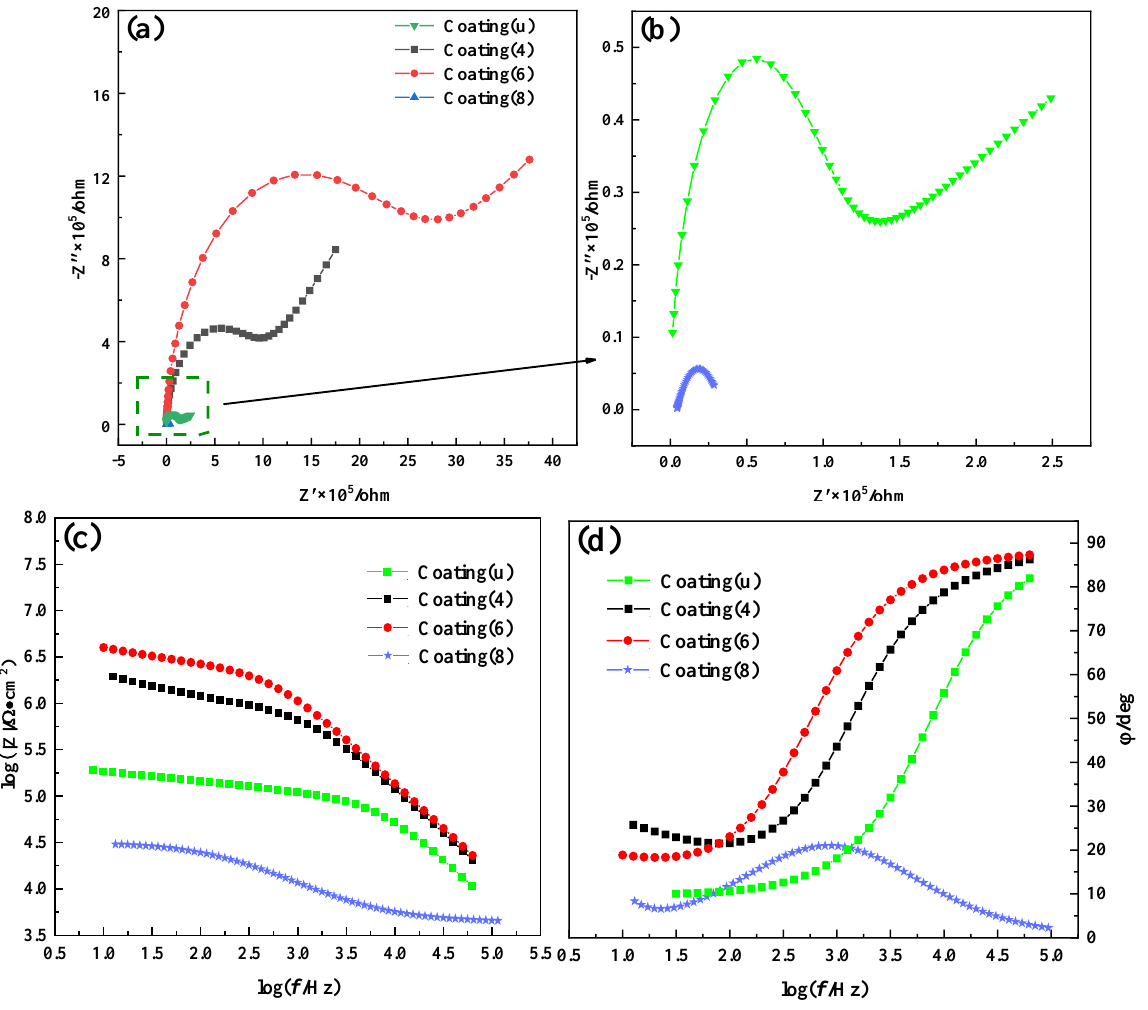
Figure 9. ( a ) Nyquist plots of coating(u) and coating(x) (x = 4, 6, 8); ( b ) magnified view of coating(u) and coating(8); ( c ) impedance frequency diagram of coating(u) and coating(x) (x = 4, 6, 8); ( d ) phase frequency diagram of coating(u) and coating(x) (x = 4, 6, 8).